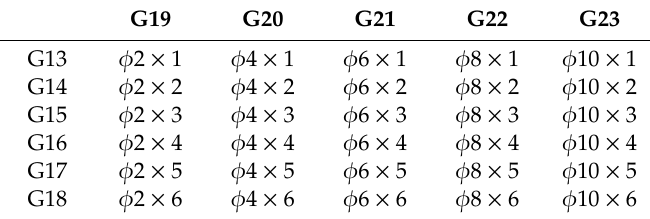
Table 8. Parameters associated with the corrosion pit specimen. ( φ pr × pd) (mm).